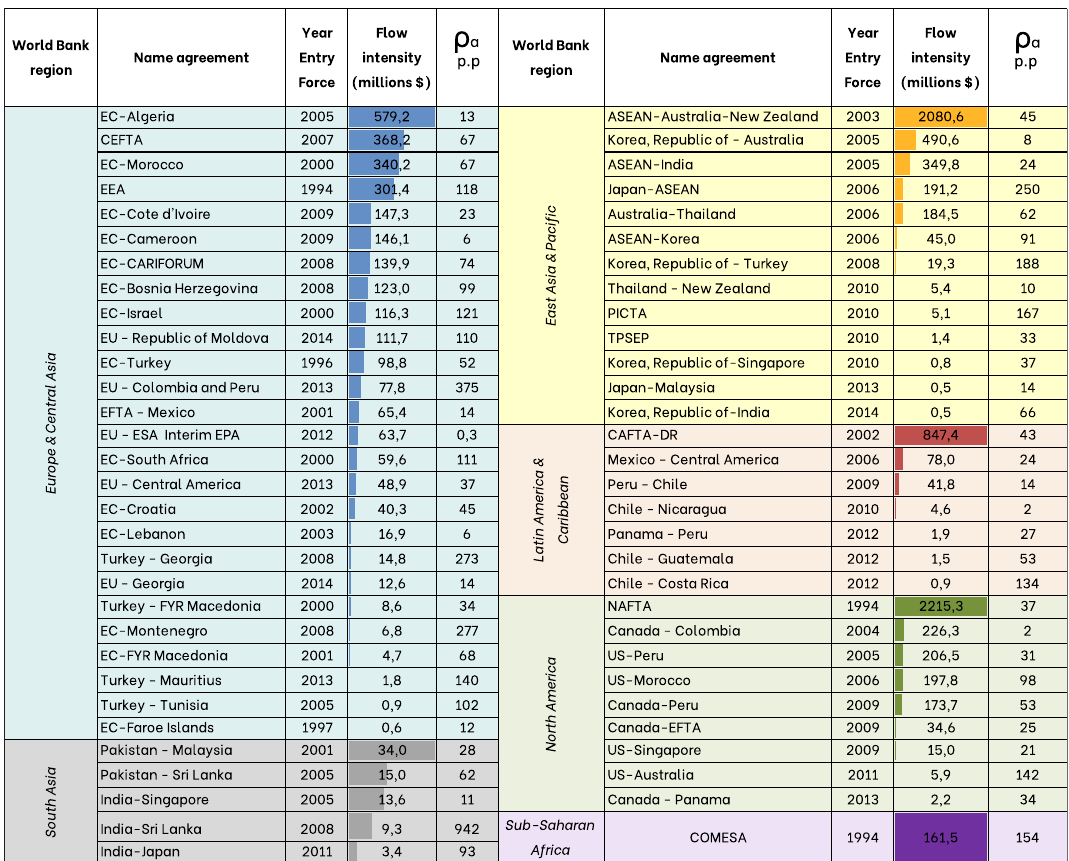
Table 4. Flow values in millions of dollars in year t and percent changes ρ a from t − 1 to t for each trade agreement. Year t indicates the year of entry into force of the trade agreement. Colors highlight the geographical region as provided by the World Bank, considering most of the countries that are part of the trade agreement. In the case of a bilateral trade agreement, the geographical position of the first country mentioned in the actual name of the treaty is taken into account to assign the color. For each region, trade agreements are sorted in descending order according to the flow value ($ million). The color and orientation of the arrows classify the percentage changes into three categories: gray for a moderate increase concerning links not covered by agreements ( < 50% increase in flow intensity), yellow for a strong increase (increase ≥ 50% and < 100%), and green for sharp increase (increase ≥